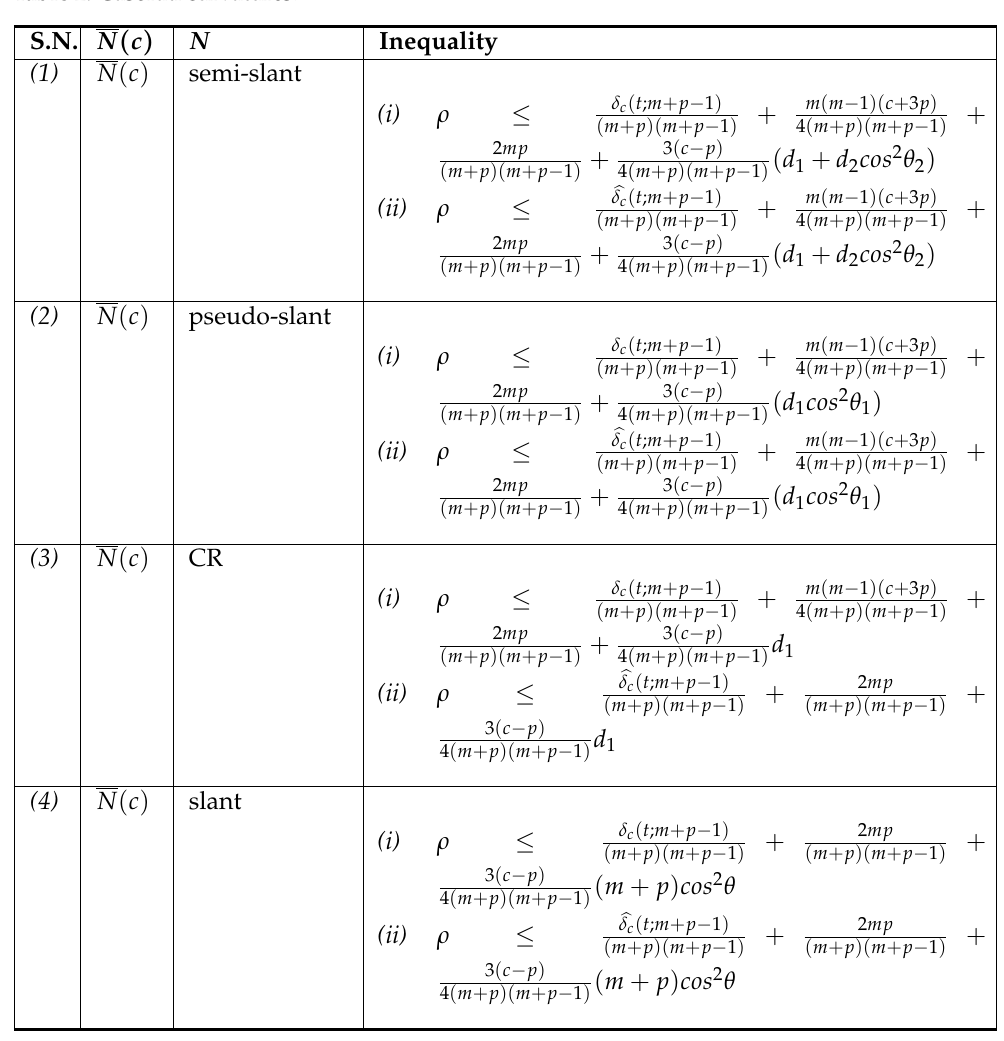
Table 2. Casorati